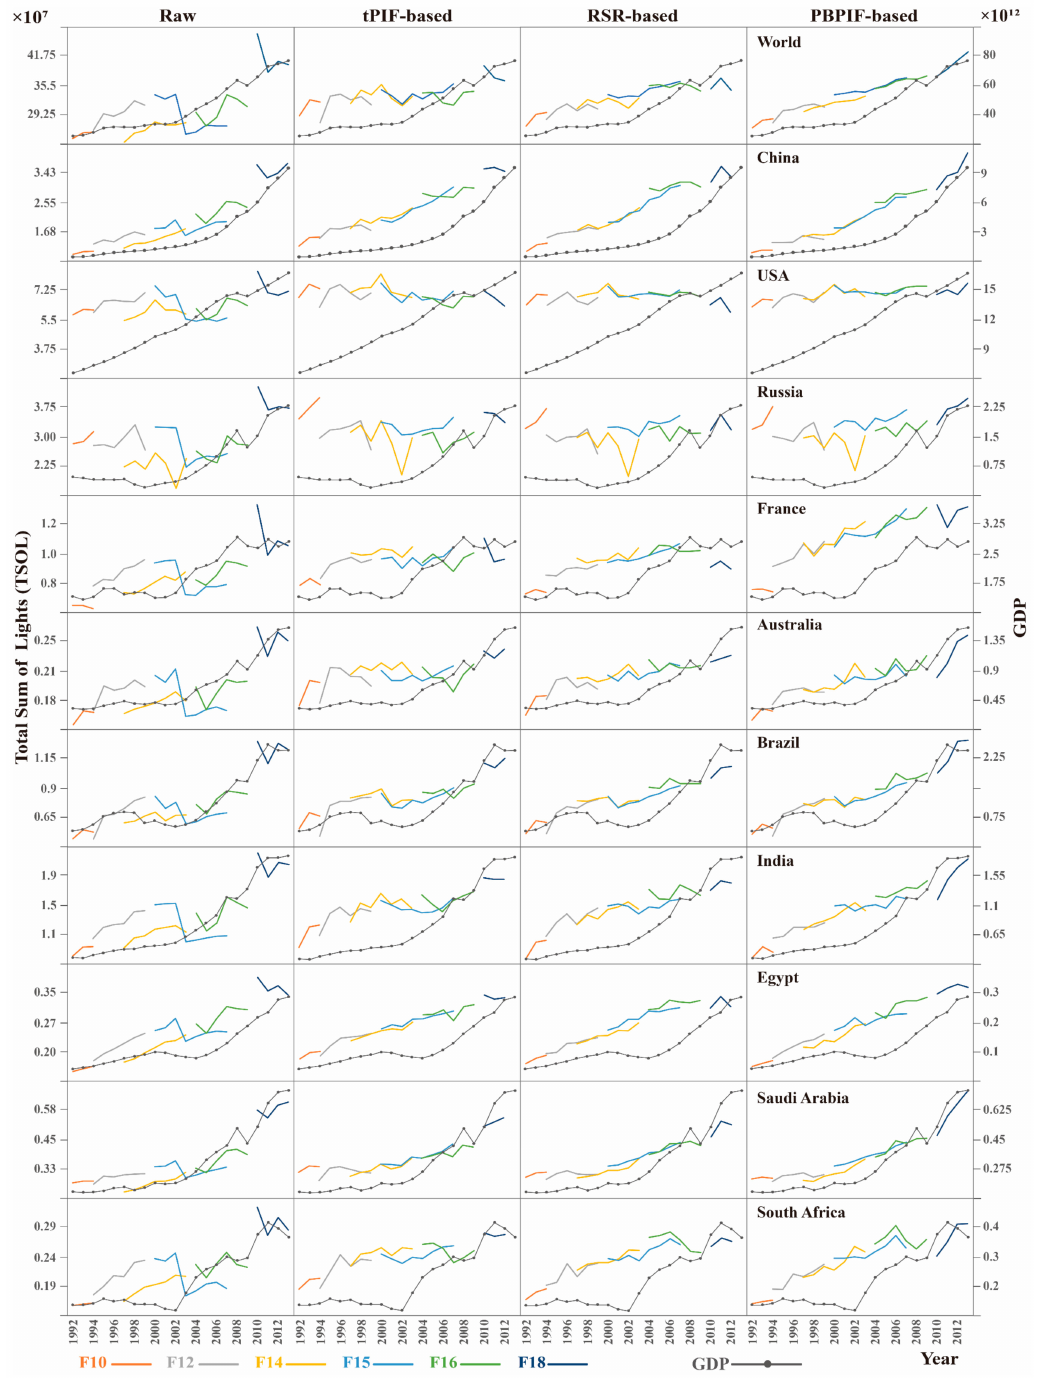
Figure 7. TSOL of time series NTL datasets in global and di ff erent